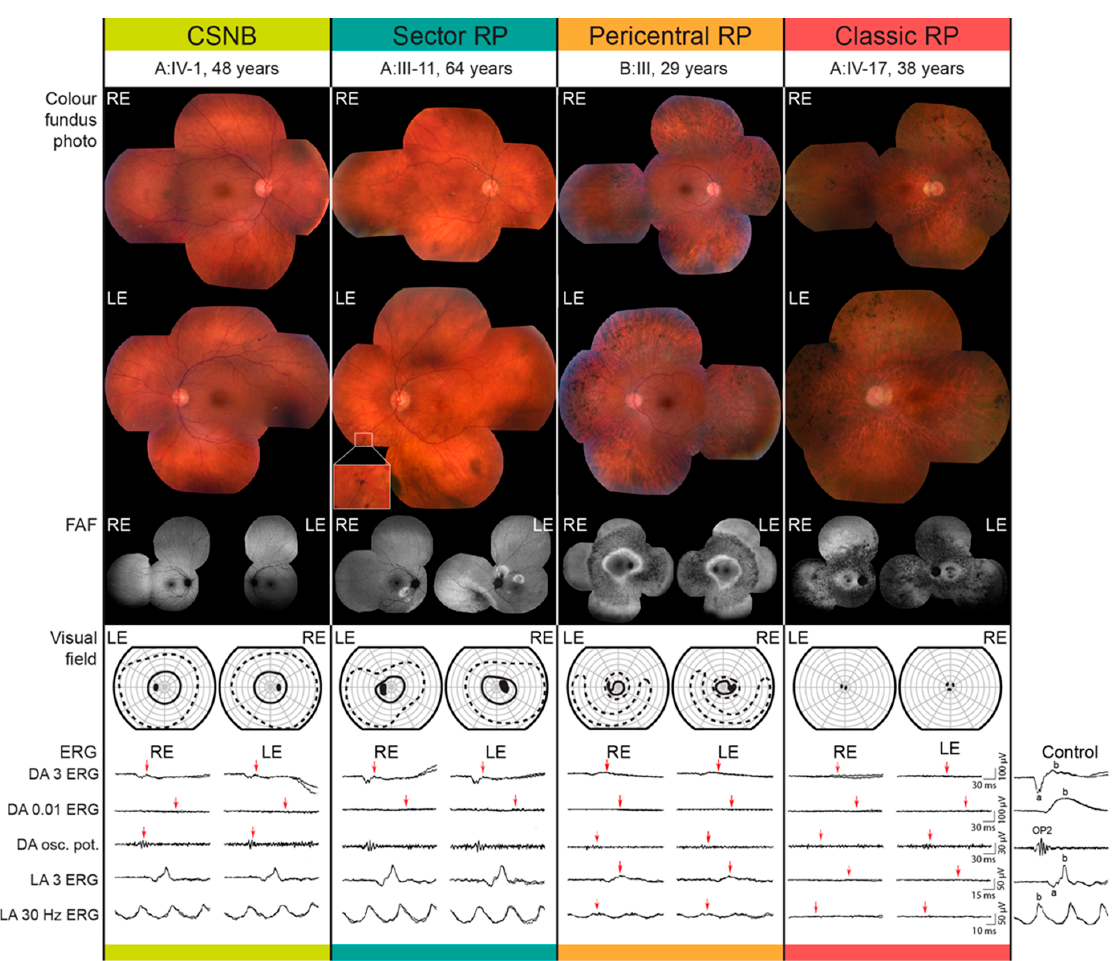
Figure 3. Representative cases from each phenotypic group. Color fundus photo, fundus autofluorescence (FAF), Goldmann visual field and full field electroretinography data are shown for representative patients from each phenotypic group. Different stimuli-recording protocol used for the full-field ERG recording is stated on the left and was chosen according to the standards and guidelines of the International Society for Clinical Electrophysiology of Vision (see Methods). Red arrows mark the deviation from the laboratory normatives. The ERG traces of a representative healthy control subject are shown on the right. Abbreviations: RE—right eye; LE—left eye; BCVA—best corrected visual acuity; ERG— electroretinography; DA—dark adapted; LA—light adapted.